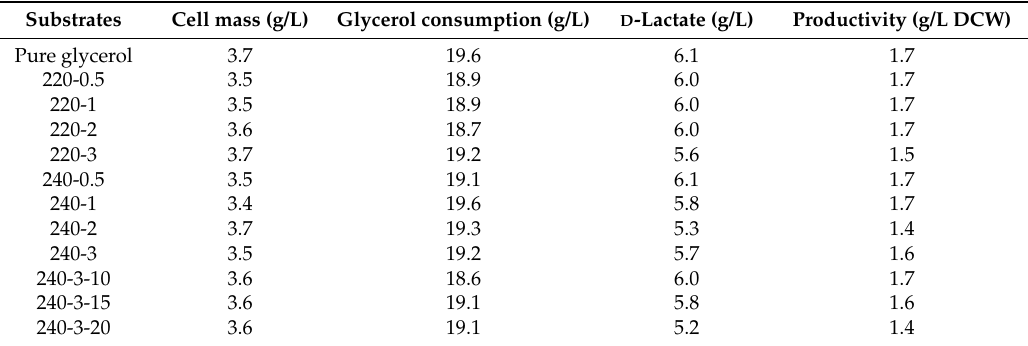
Table 1. The fermentation of the recovered glycerol. DCW: dry cell weight.